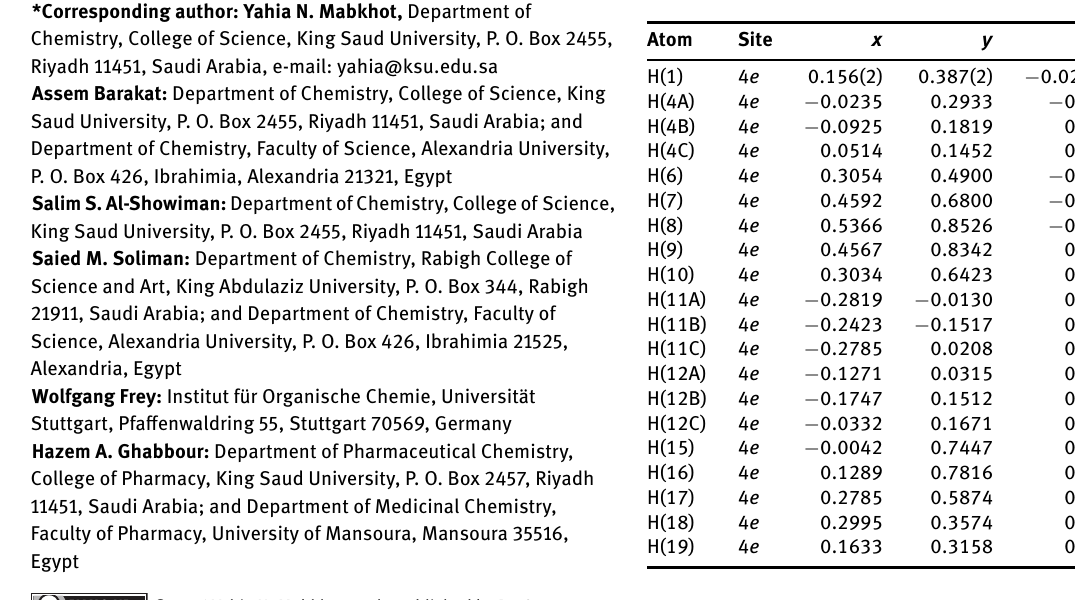
Table 2: Fractional atomic coordinates and isotropic or